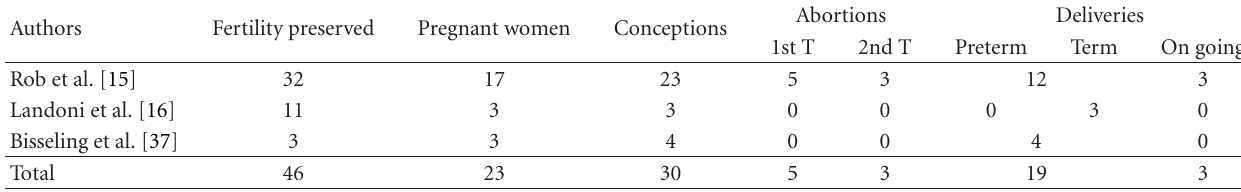
Table 7: Pregnancy outcomes for less radical procedures.